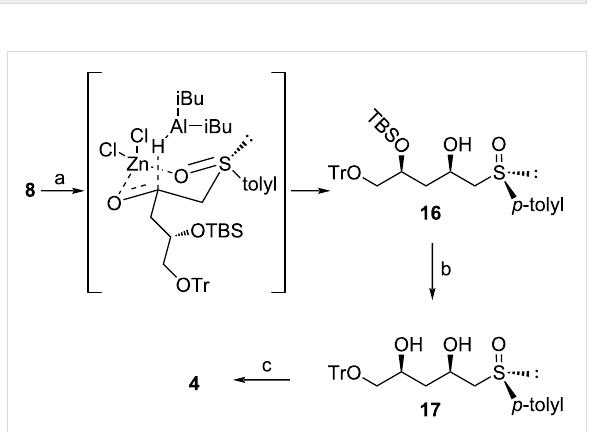
Scheme 3: Sequence showing the source of compound 9